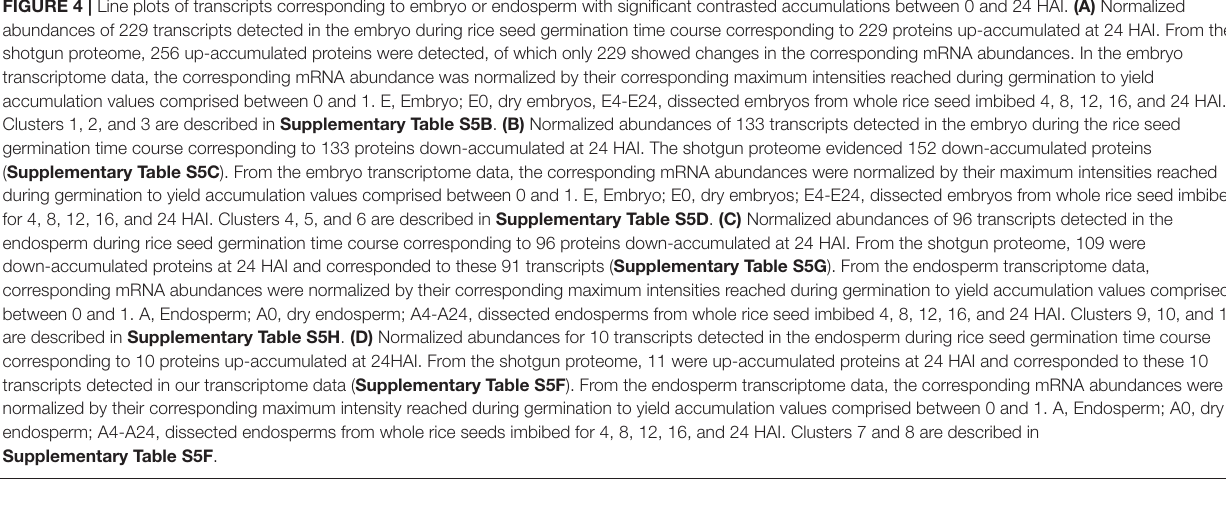
The corresponding transcripts were grouped according to two major clusters ( Supplementary Table S5F , Figure 4D ). All